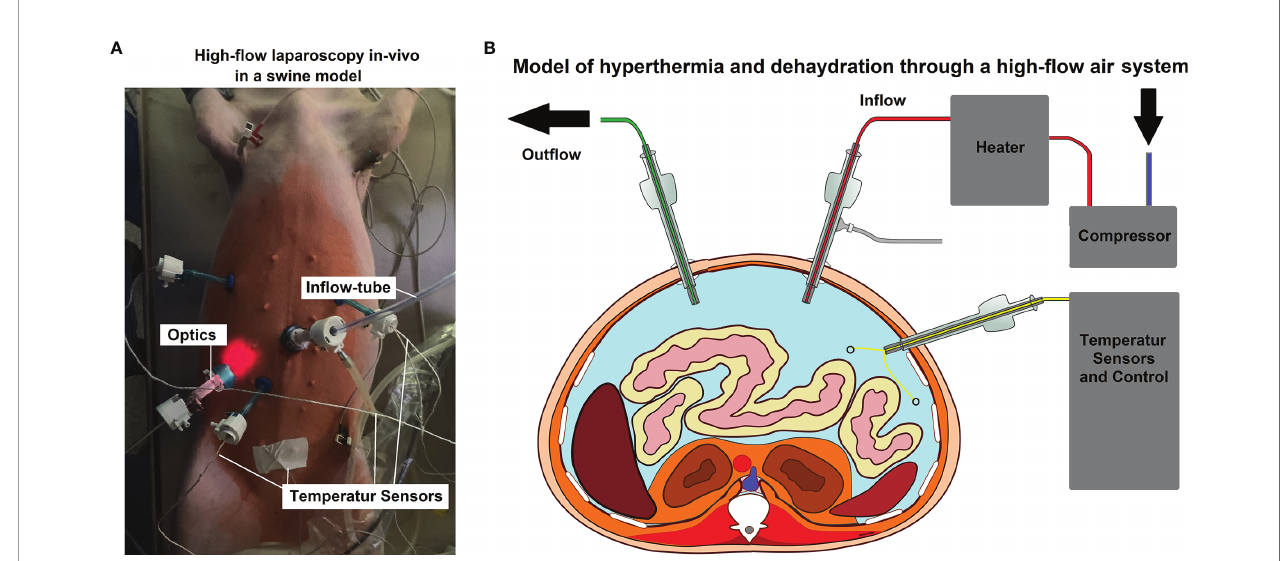
FIGURE 1 | (A) In-vivo high- fl ow laparoscopy model to evaluate dehydration and hyperthermic air fl ow effects. (B) Model of the laparoscopic setting. Two trocars are used as in- and out fl ow while other trocars are placed for optics and temperature